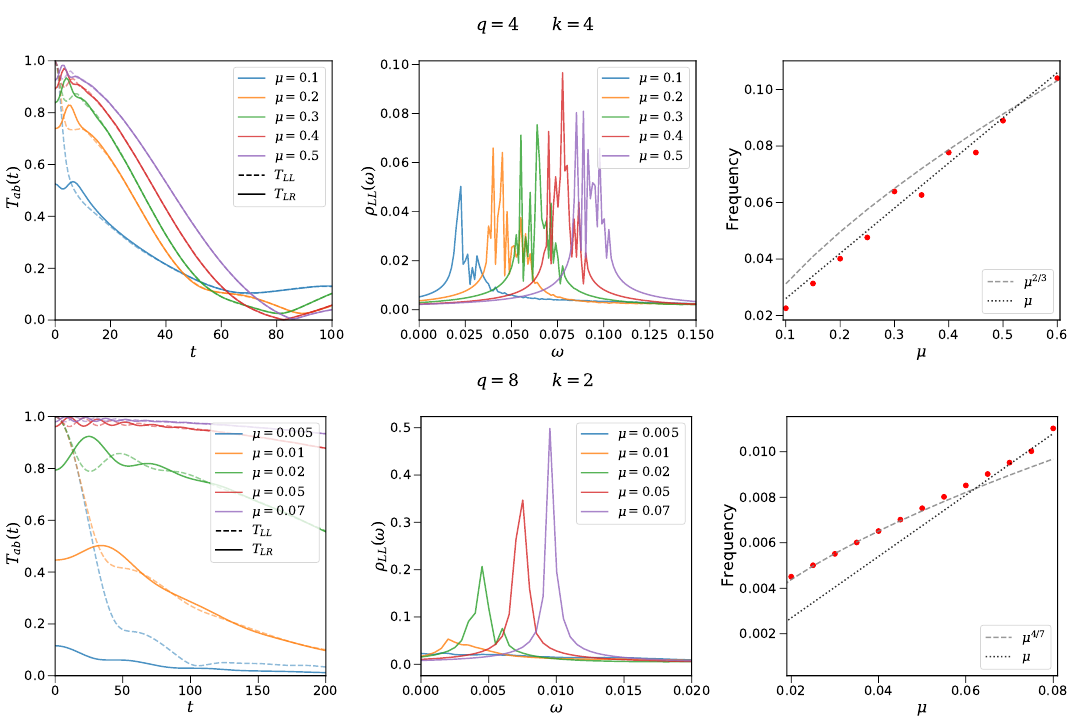
Figure 9. Transmission amplitude T ab at zero temperature (5.7) (left), the spectral function ρ LL (5.4) (center), and the characteristic frequency of oscillations of the Green’s function (right) for 2 N = 40 , q = 4 , k = 4 (top) and q = 8 , k = 2 (bottom). The dashed and dotted lines represent the expected frequency scaling at weak and strong coupling, respectively, according to (4.13) and (4.16). We performed an average over 50 disorder